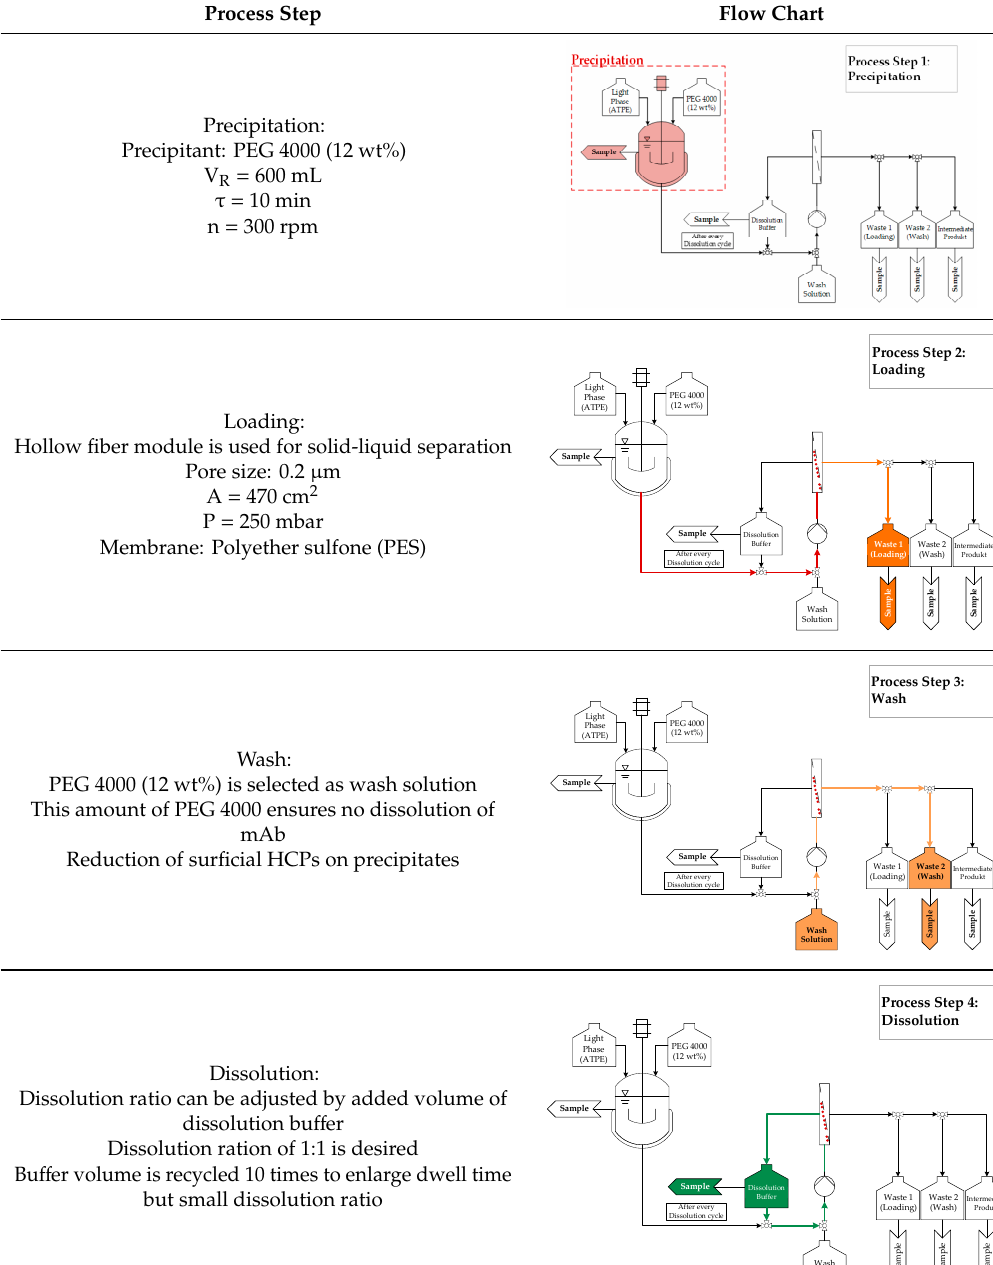
Table A2. Overview of operating procedure for deeper process comprehension. Process Step Flow Chart